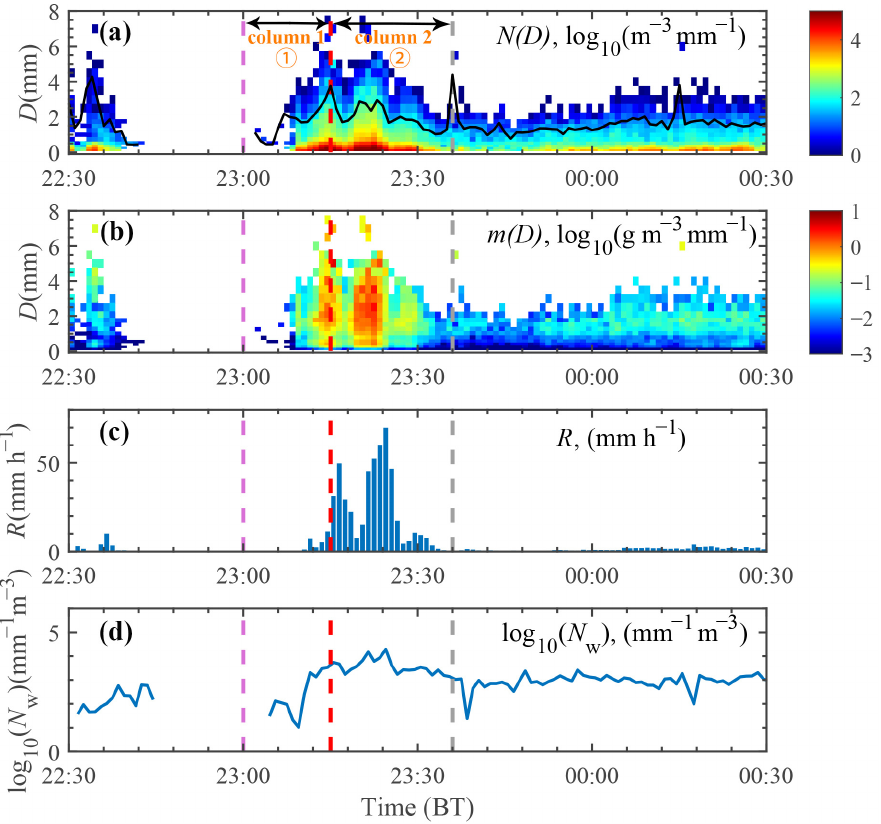
Figure 10. Time series of precipitation DSD collected by the disdrometer at Dongyang station between 2230 BT on 10 May 2021 and 0030 BT on 11 May 2021. ( a ) N (D) (the color represents the number concentration; the solid black line indicates D m ). ( b ) m (D) (the color represents the total mass of all raindrops per unit diameter range and unit volume). ( c ) R . ( d ) log 10 N w .